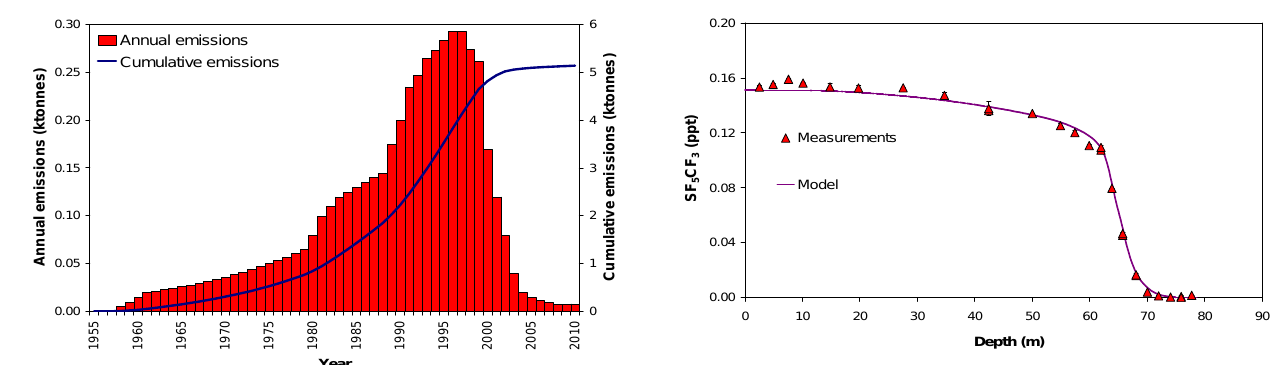
Fig. 2. The model-derived annual and cumulative emissions of SF 5 CF 3 used to produce the atmospheric model fit scenario pre- sented in Fig. 1 (the red line in Fig. 1).